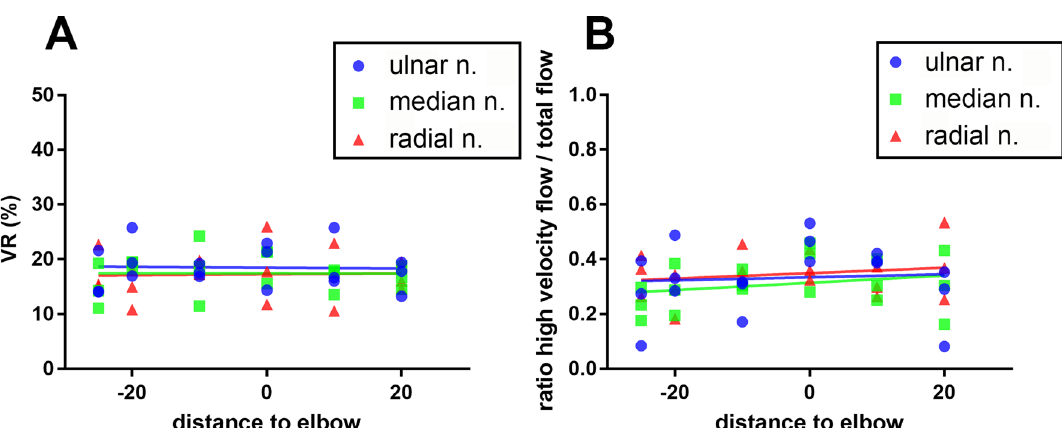
Figure 5. Longitudinal progression of the VR ( A ) and portion of high velocity blood flow ( B ) from the shoulder (negative values) to the wrist (positive values) for the ulnar, median and radial nerve of three healthy volunteers. The slopes of the trendlines do not differ significantly between the ulnar, median and radial nerve, and do not differ from zero for ( A ) and ( B ) the controls (mean non-affected nerve 14.14%; mean healthy control 17.72%), but the high velocity blood flow color Doppler signal is significantly reduced in the low perfusion neuroma (mean 0.161), while it is significantly increased in the high perfusion neuroma (mean 0.560) compared to the controls (mean unaffected nerve 0.390; mean healthy control 0.328). For the painful neuromas (2 of the 9 assessed neuromas) we found a mean VR of 30.17%, which was signifi- cantly increased compared to the VR of the non-affected nerve 14.14% and healthy control 17.72% (p ≤ 0.0001, Kruskal Wallis with Dunns multiple comparison test). There was no statistical difference of the VR of painful neuromas (mean 30.17%) compared to non-painful neuromas (mean 43.37%).